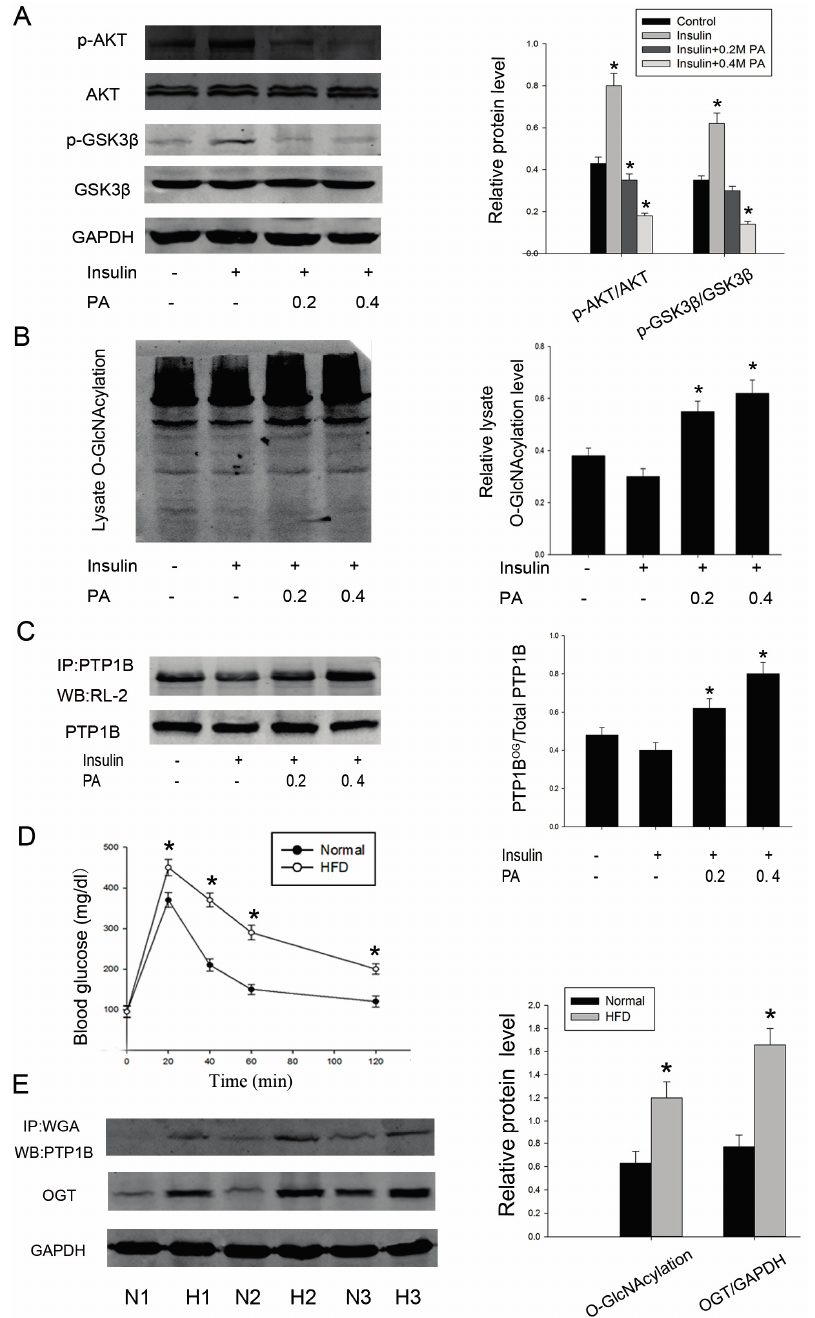
Figure 2. O -GlcNAcylation of PTP1B is increased in insulin resistance. Human HepG2 cells were treated with palmitate (0/0.2/0.4 mmol/L) for 24 h before being stimulated with insulin for 20 min. ( A ) Proteins were extracted and the phosphorylation of Akt and GSK3 β was measured by western blot analysis; ( B ) O -GlcNAcylation of total cell lysate was analyzed; ( C ) O -GlcNAcylation of PTP1B was evaluated by immunoprecipitation followed by western blot analysis; ( D ) mice insulin resistance model and glucose tolerance test; ( E ) hepatic tissues were obtained from three groups of mice fed a normal or a high fat diet, respectively. O -GlcNAcylation of PTP1B and expression of OGT were measured. Similar results were obtained in two other experiments. ( n = 3, * p < 0.05, significantly different from respective